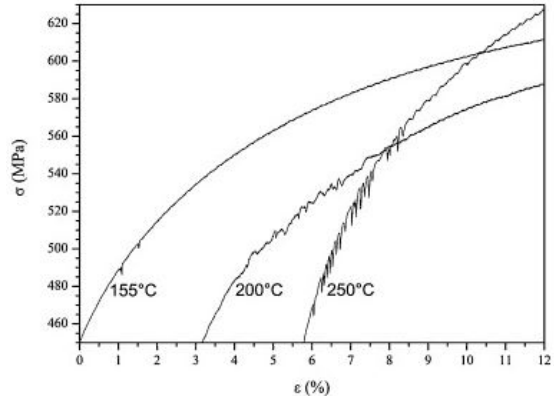
Figure 33. Serrations in the stress–strain curves at a strain rate of 10 − 3 s − 1 at different temperature for 0.10%C DP steel [194] .